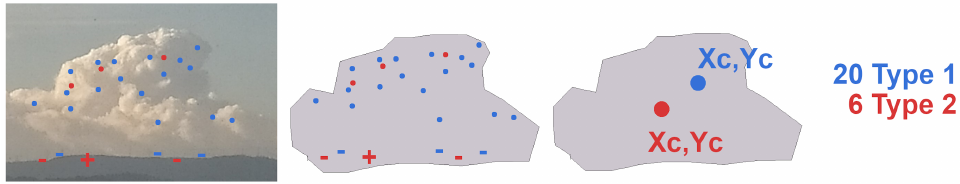
Figure 3. Idealised identification of different types of sources in a thunderstorm and its idealistic transformation into two centroids, which characterise the storm at a certain